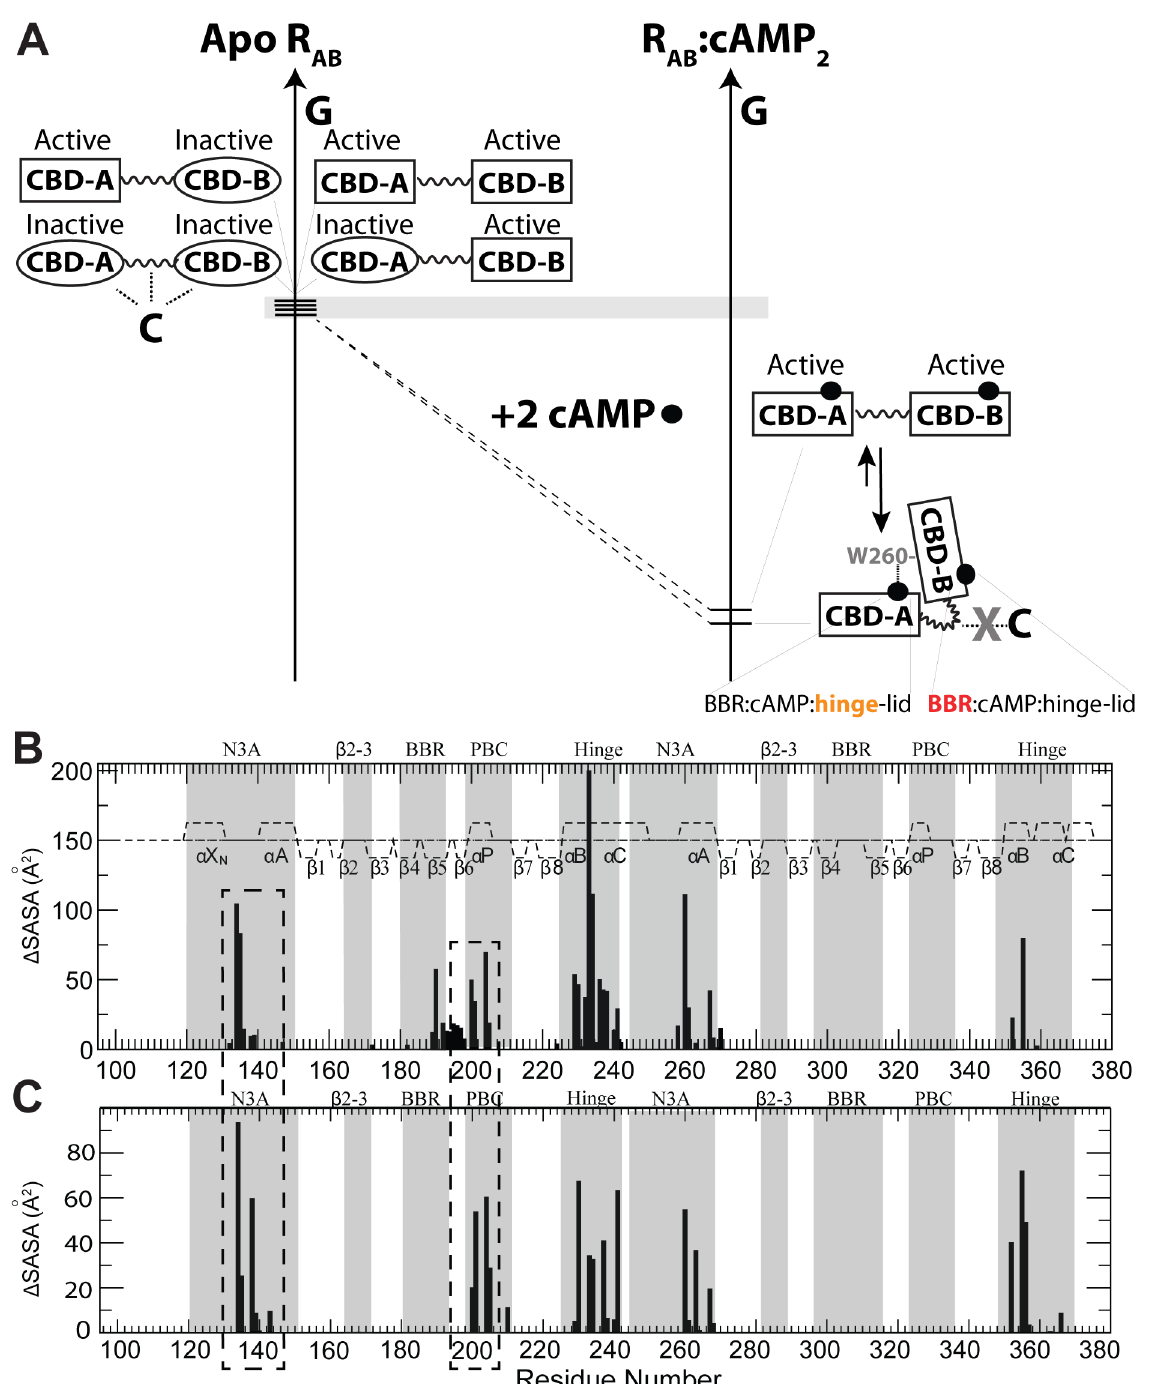
Fig 6. (A) “ Double Conformational Selection ” Model proposed for PKA-RI α activation. The inactive and active states of each CBD are represented through ovals and rectangles, respectively. The grey horizontal bar indicates that free energy differences are minimal (i.e., of the order of ~RT). Dotted lines denote interactions with the C-subunit of PKA. cAMP is shown as solid black circles. R AB refers to the PKA-RI α region spanning the two tandem cAMP-binding domains (CBD-A and -B). The cAMP recognition motifs for both CBDs are reported as BBR:cAMP:hinge-lid, where BBR stands for base-binding region. Orange (red) denotes enhanced ms- μ s (ps-ns) dynamics. See text in the Discussion for a full explanation. (B) Inter-domain contact profile based on the structure of cAMP 2 -bound RI α (91 – 379) (PDB Code: 1RGS) and SASA changes occurring upon deletion of the 113 – 232 region (for contacts in the 233 – 376 segment) or the 233 – 376 region (for contacts in the 113 – 232 segment). The boundary between the two deleted regions (i.e., residues 232 – 233) is based on the observation that the 233 – 244 region is flexible in RI α (91 – 244):cAMP (46). (C) Profile of RI α (91 – 379):C contacts as mapped by SASA variations